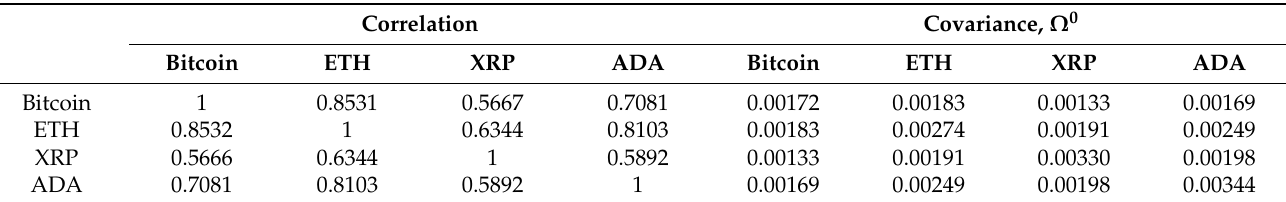
Table 6. Correlation and covariance of cryptocurrency